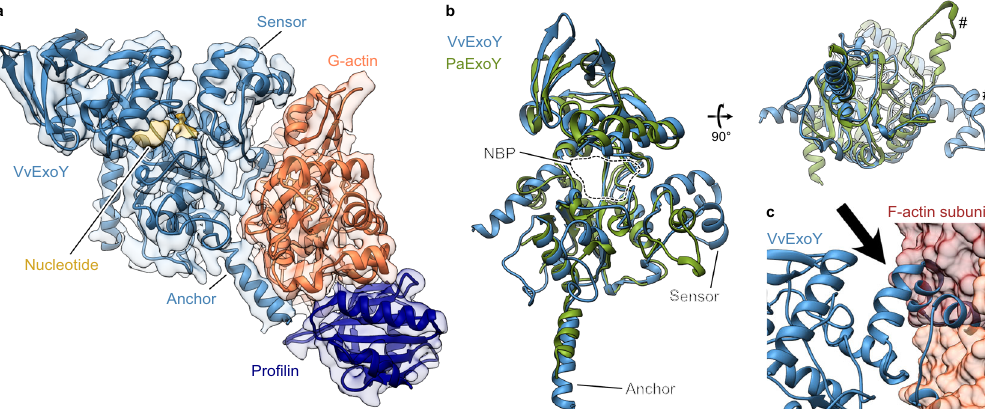
Fig. 3 Cryo-EM structure of the VvExoY-G-actin-pro fi lin complex. a An atomic model of the complex fi t in the cryo-EM density that was combined from two maps (Supplementary Fig. 7c). VvExoY is in light blue, G-actin is in orange, pro fi lin is in dark blue. b Alignment of atomic models of PaExoY (green) and VvExoY (light blue). Hashtags indicate the major difference in the sensor of the toxins. NBP nucleotide-binding pocket. c Docking of the VvExoY structure to F-actin shows a steric clash (arrow) between the central interaction region of VvExoY and the F-actin